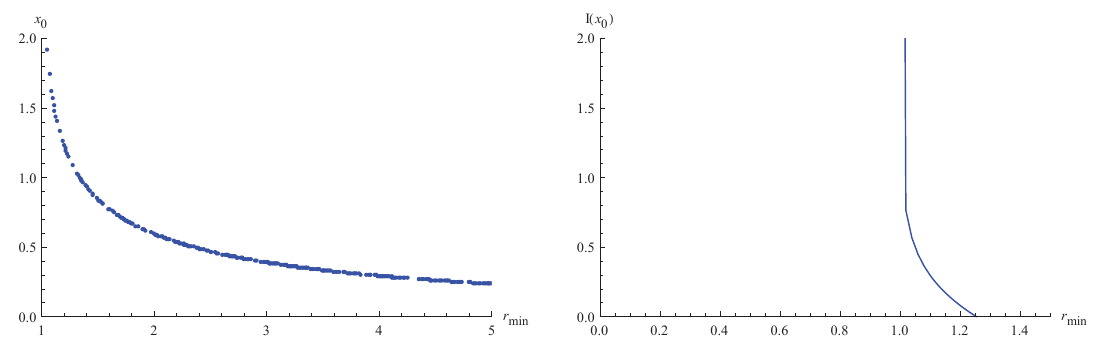
Figure 2 . Left: the relation between the width of the strip x 0 and r min . Right: the relation between the mutual information I ( x 0 ) and the position of the turning point r min . For both cases, we set m = 0 : 6, Q = 2, and r h = 1.